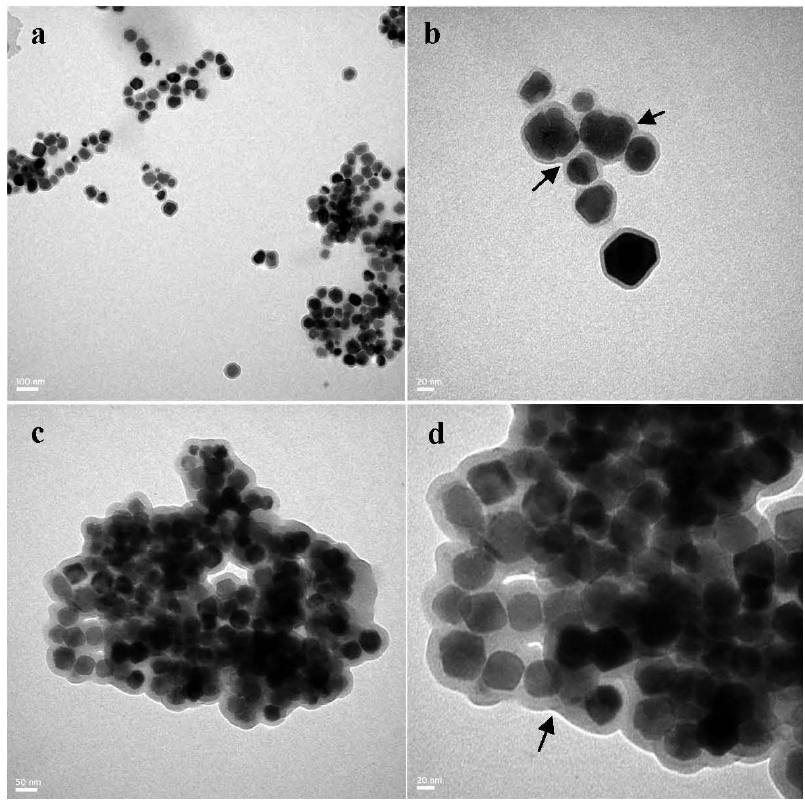
Figure 1. TEM images of bacterial magnetosomes (BMs) and Ara-C-coupled BMs (ABMs): ( a and b : BMs) and ( c and d : ABMs); ( b ) BMs showed the narrow size distribution and uniform lipid membrane; ( d ) Black arrow pointed to thickened and blurred materials surrounding